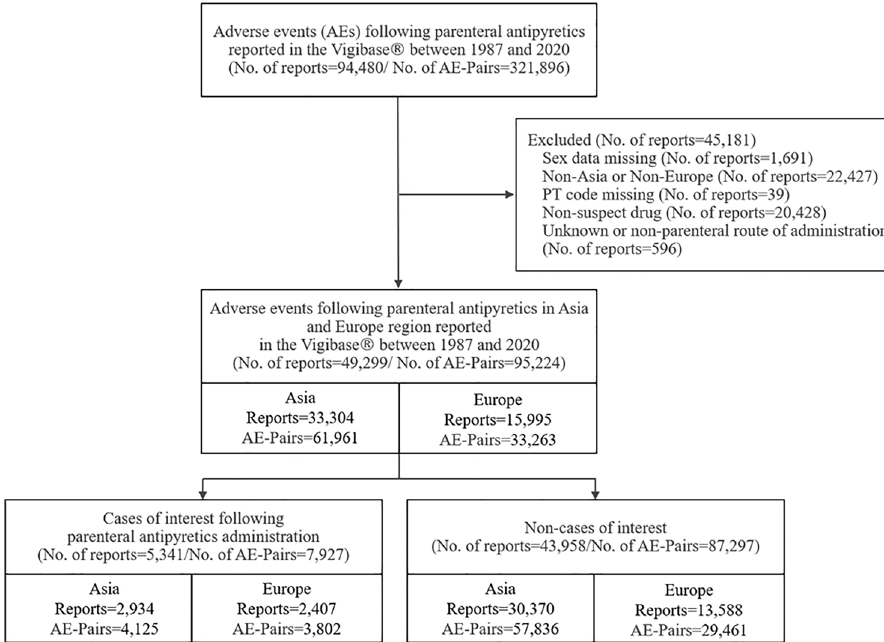
Figure 1. Study flowchart for patient selection of parenteral antipyretics study in VigiBase (1987–2020). AE adverse events, PT preferred